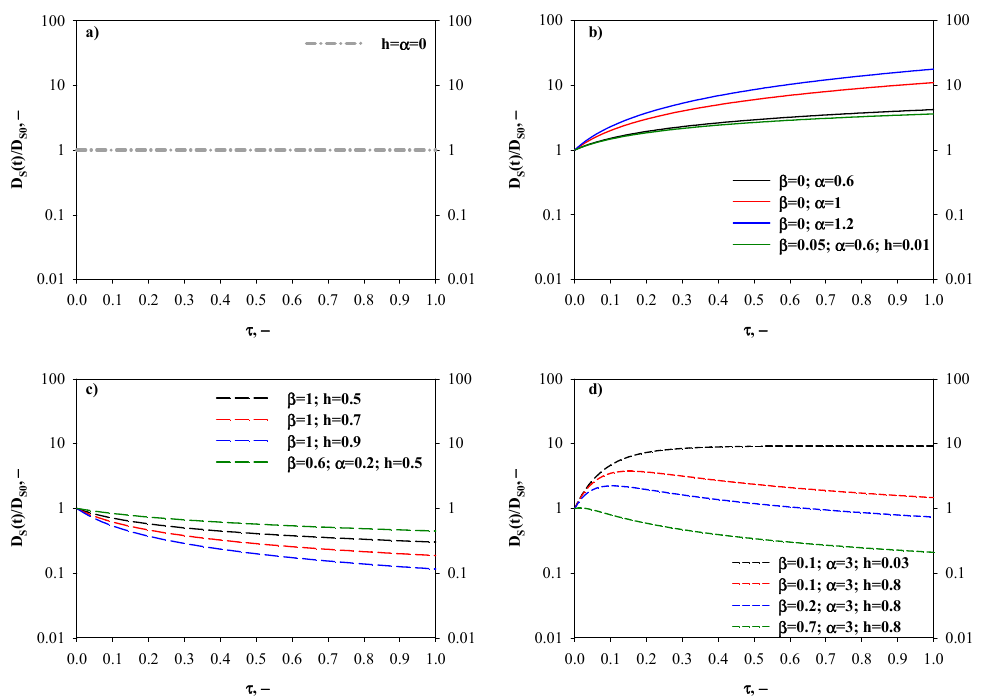
Figure 2. Different patterns of the surface diffusivity ratio as a function of the dimensionless time, predicted by the developed time-dependent MBI Equation (15): ( a ) time-invariant function; ( b ) monotonically increasing function; ( c ) monotonically decreasing function; ( d ) function exhibiting a maximum.